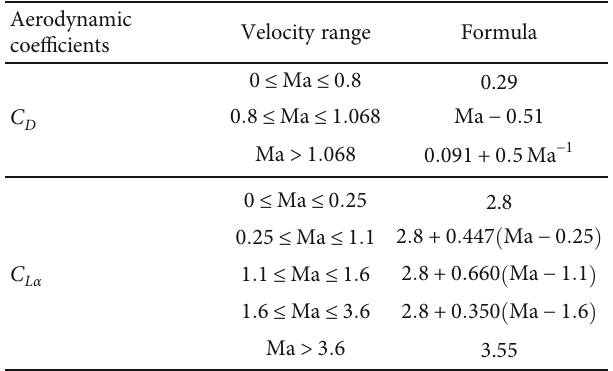
Table 3: Approximation aerodynamic coe ffi cients of the “ Titan II ”